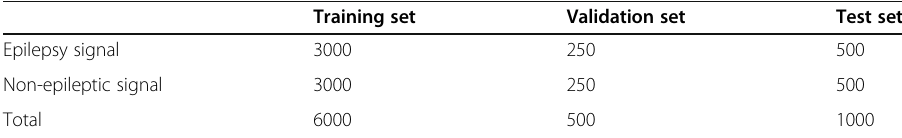
Table 1 Data allocation